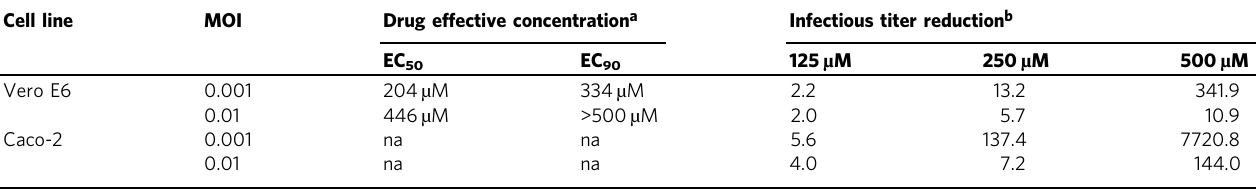
Table 1 In vitro ef fi cacy of